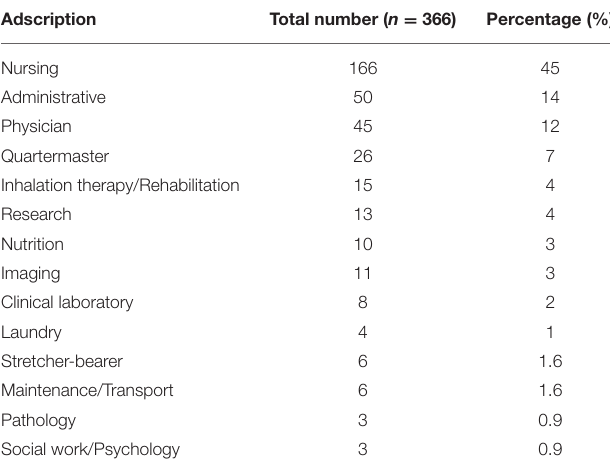
TABLE 1 | Assigment of institute workers positive to SARS-CoV-2 infection.